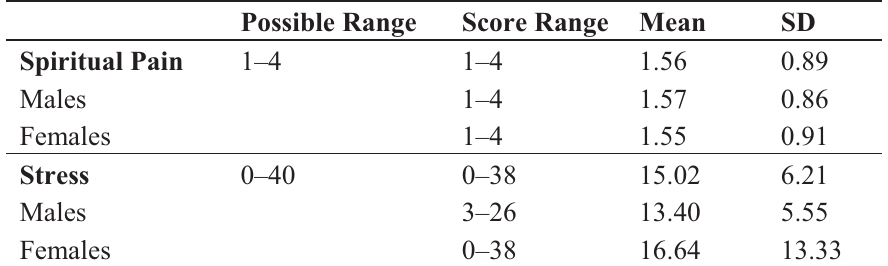
Table 2. Descriptive data for psychometric and biologic measures ( N =